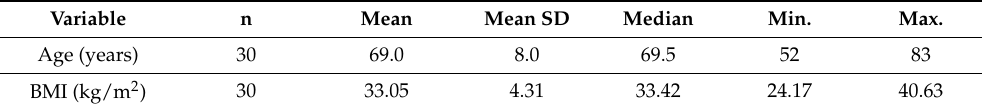
Table 2. Patients’ statistics information.